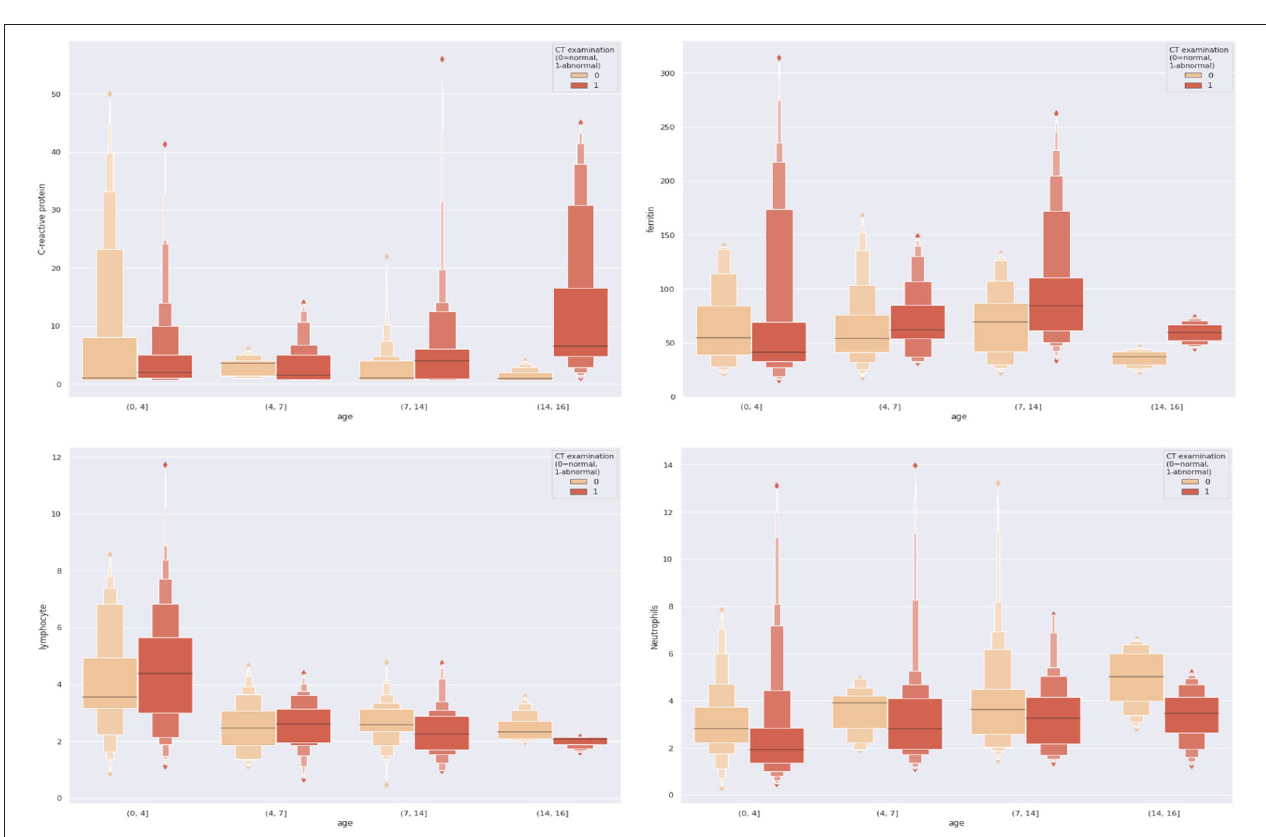
Bold values indicate the best performed method.